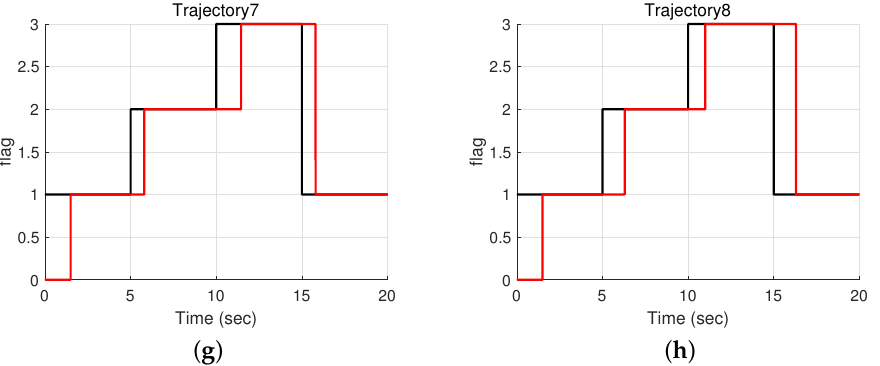
Figure 4. Online fault detection results in simulation. CW is clockwise and CCW is counterclock- wise rotation. ( a ) Linear y = x . ( b ) Linear y = − x . ( c , g ) circular (CCW). ( d , h ) circular (CW). ( e ) Clover (CCW). ( f ) Clover (CW).